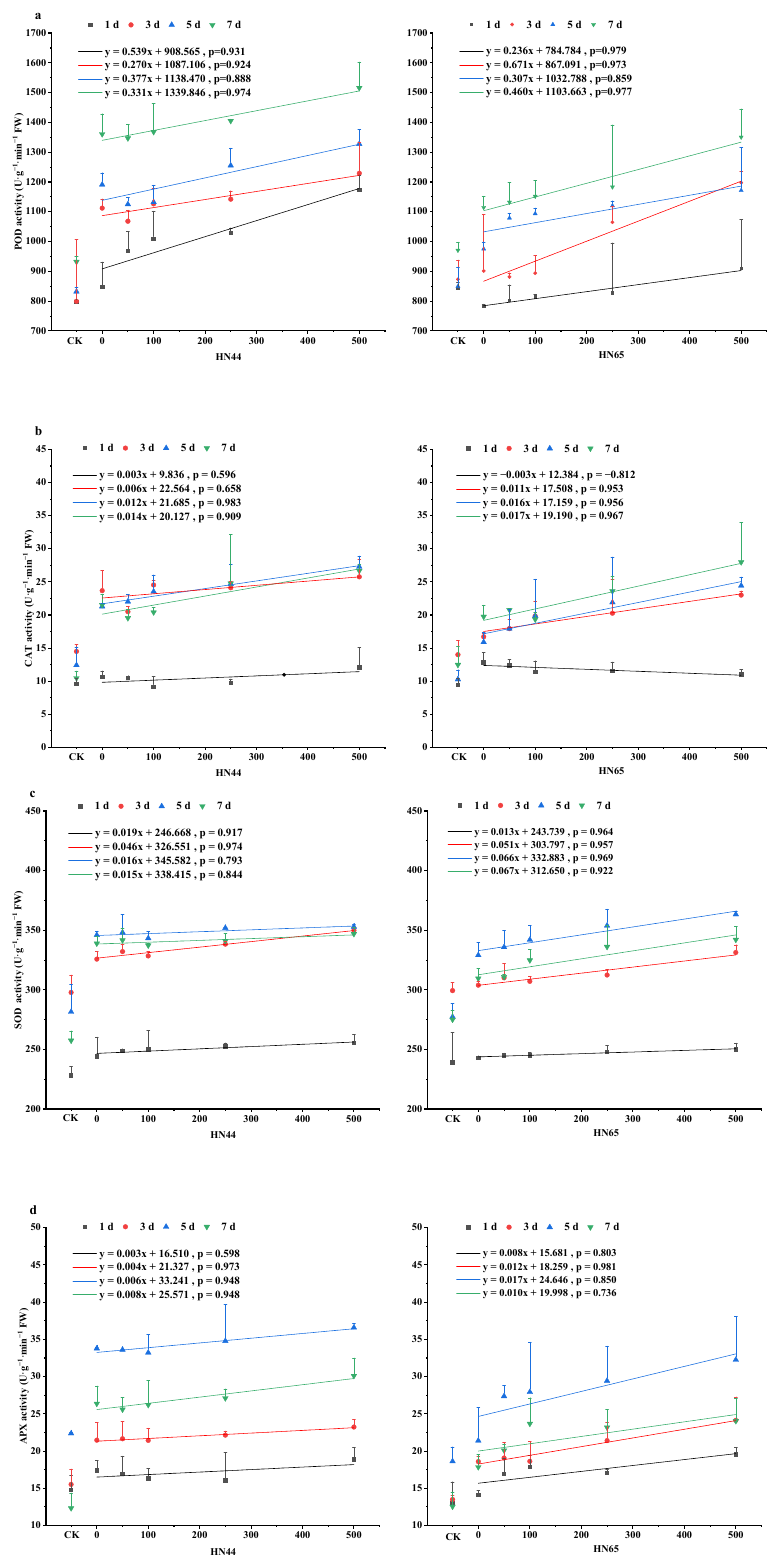
Figure 3. Changes in Antioxidant Enzyme activities during NO relieving drought stress. ( a ) peroxidase (POD) activity, ( b ) catalase (CAT) activity, ( c ) superoxide dismutase (SOD) activity, ( d ) ascorbate oxidase (APX) activity. The X -axis, CK represents the control, and the remaining numbers are SNP concentrations sprayed. The values (means ± SE) are the averages of three independent experiments.